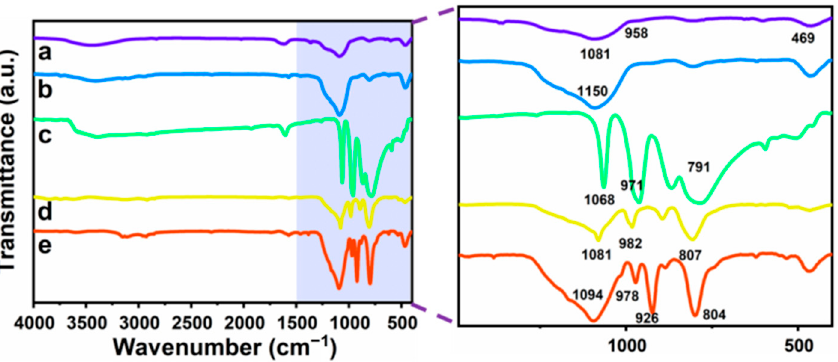
Figure 4. FTIR spectra of MCF (a), [BMIM]Cl-based MCF (b), [BMIM] 3 PMo 12 O 40 -based MCF (c), [BMIM] 3 PW 12 O 40 -based MCF (d), and [BMIM] 4 SiW 12 O 40 -based MCF (e).